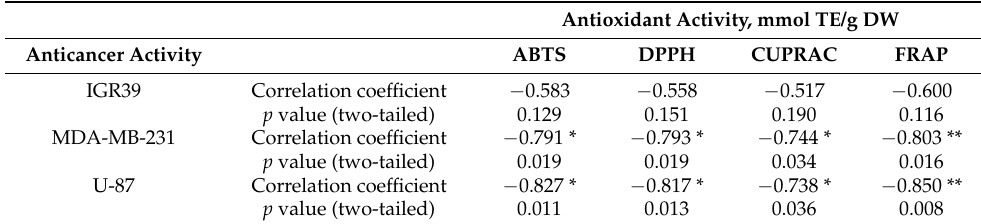
Table 4. Correlation between antioxidant and anticancer activity of tested plant